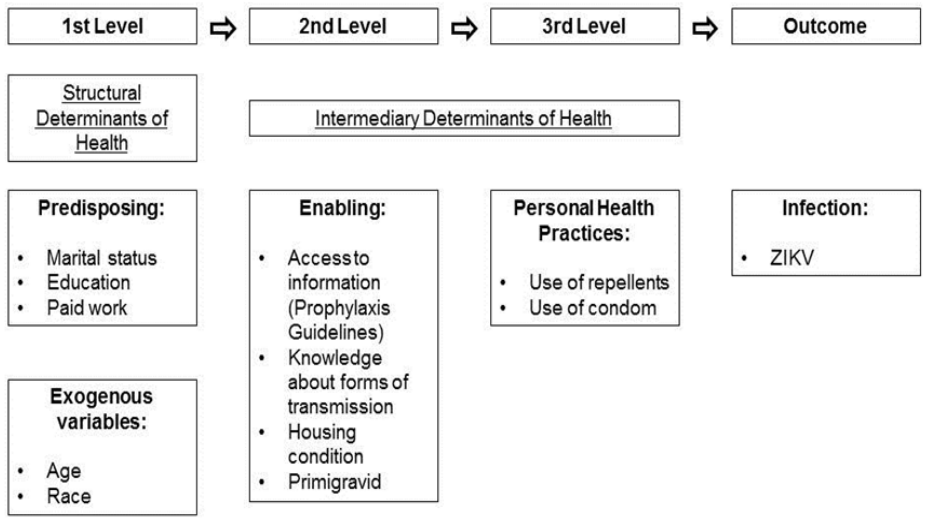
Figure 1. Conceptual